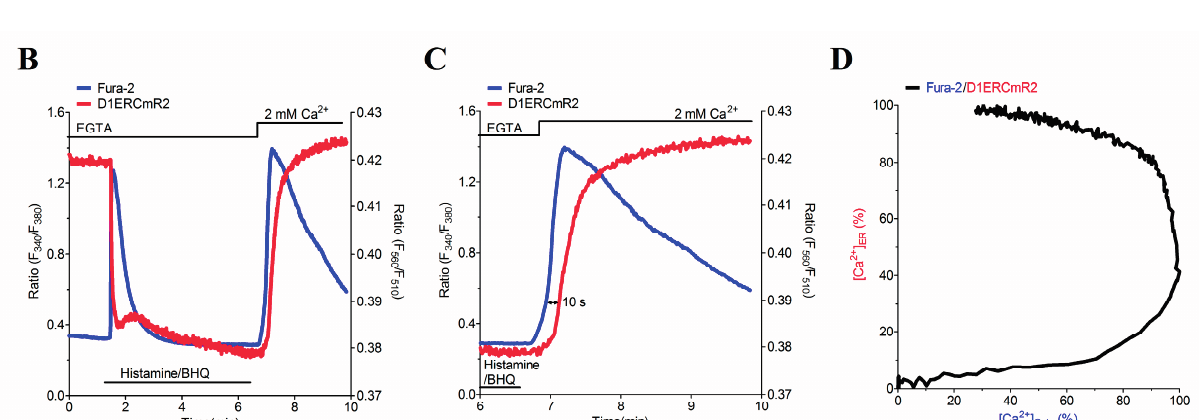
Figure 5. Dual visualization of fura-2 and D1ERCmR2 in single individual HeLa cells. ( A ) Confocal images of D1ERCmR2 expressing and fura-2 loaded HeLa cells. Subcellular structures of D1ERCmR2 were either illuminated at 473 or 515 nm and emissions were recorded at 525 (Clover, upper left panel) or 570 nm (mRuby2, upper right panel), respectively. Fura-2 was excited at 405 and emitted light was imaged at 460 nm (lower left panel). Images overlaid (lower right panel); ( B ) Representative curves of cytosolic and ER [Ca 2+ ] in a single HeLa cell treated with 100 µM Histamine and 15 µM BHQ in a nominal Ca 2+ free buffer and subsequent readdition of 2 mM Ca 2+ ; ( C ) Zoom into event of SOCE reveals a delayed ER Ca 2+ refilling; ( D ) Spatiotemporal correlation of [Ca 2+ ] Cyto and [Ca 2+ ] ER during SOCE in percentage of the maximum increase shown in panel